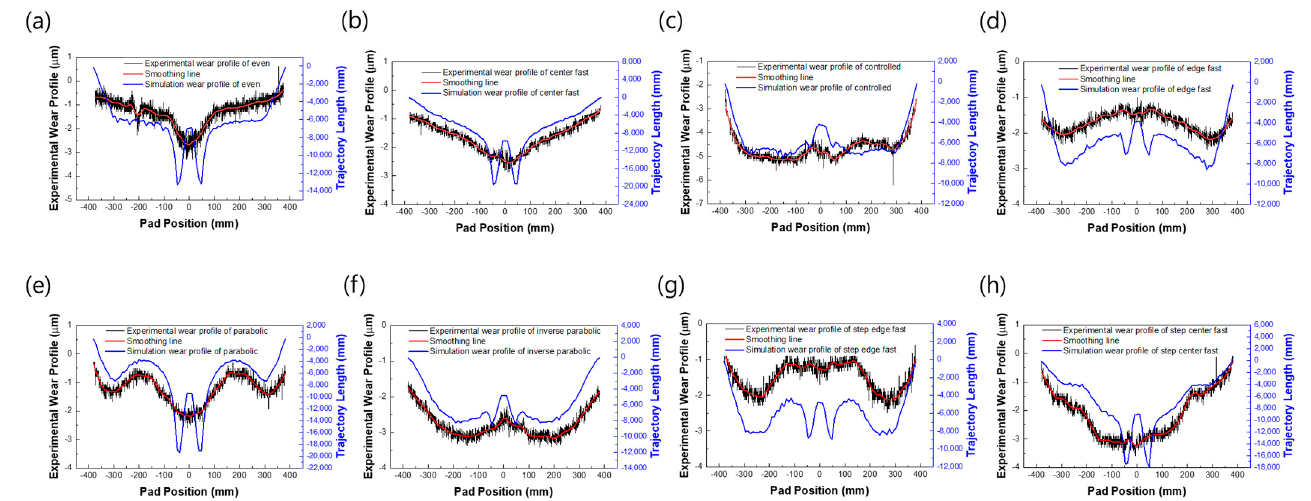
Figure 9. Results of comparing actual shape and predicted shape under eight ROT conditions: ( a ) Even, ( b ) Linear center fast, ( c ) Linear edge fast, ( d ) Controlled, ( e ) Parabolic, ( f ) Inverse parabolic, ( g ) Step edge fast, and ( h ) Step center fast.